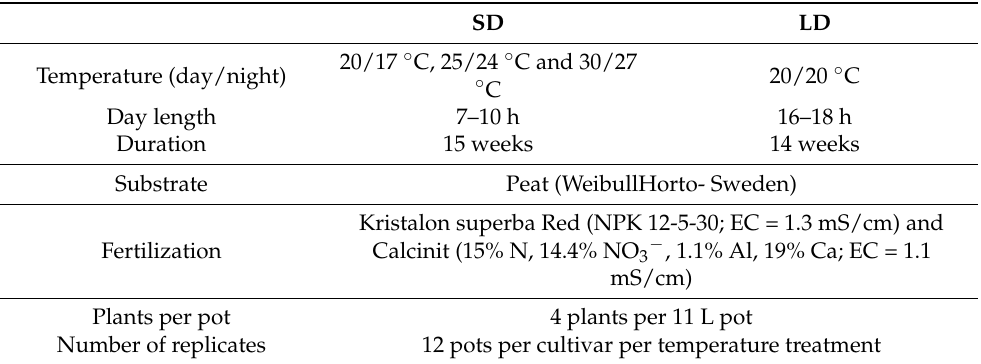
Table 1. Experimental set up with the two everbearing strawberry cultivars ‘Florentina’and ‘Favori’, conducted in a greenhouse at Alnarp, Sweden, under ambient short day (SD), long day (LD) and temperatures conditions as indicated. SD LD 20/17 ◦ C, 25/24 ◦ C and 30/27 Temperature (day/night)